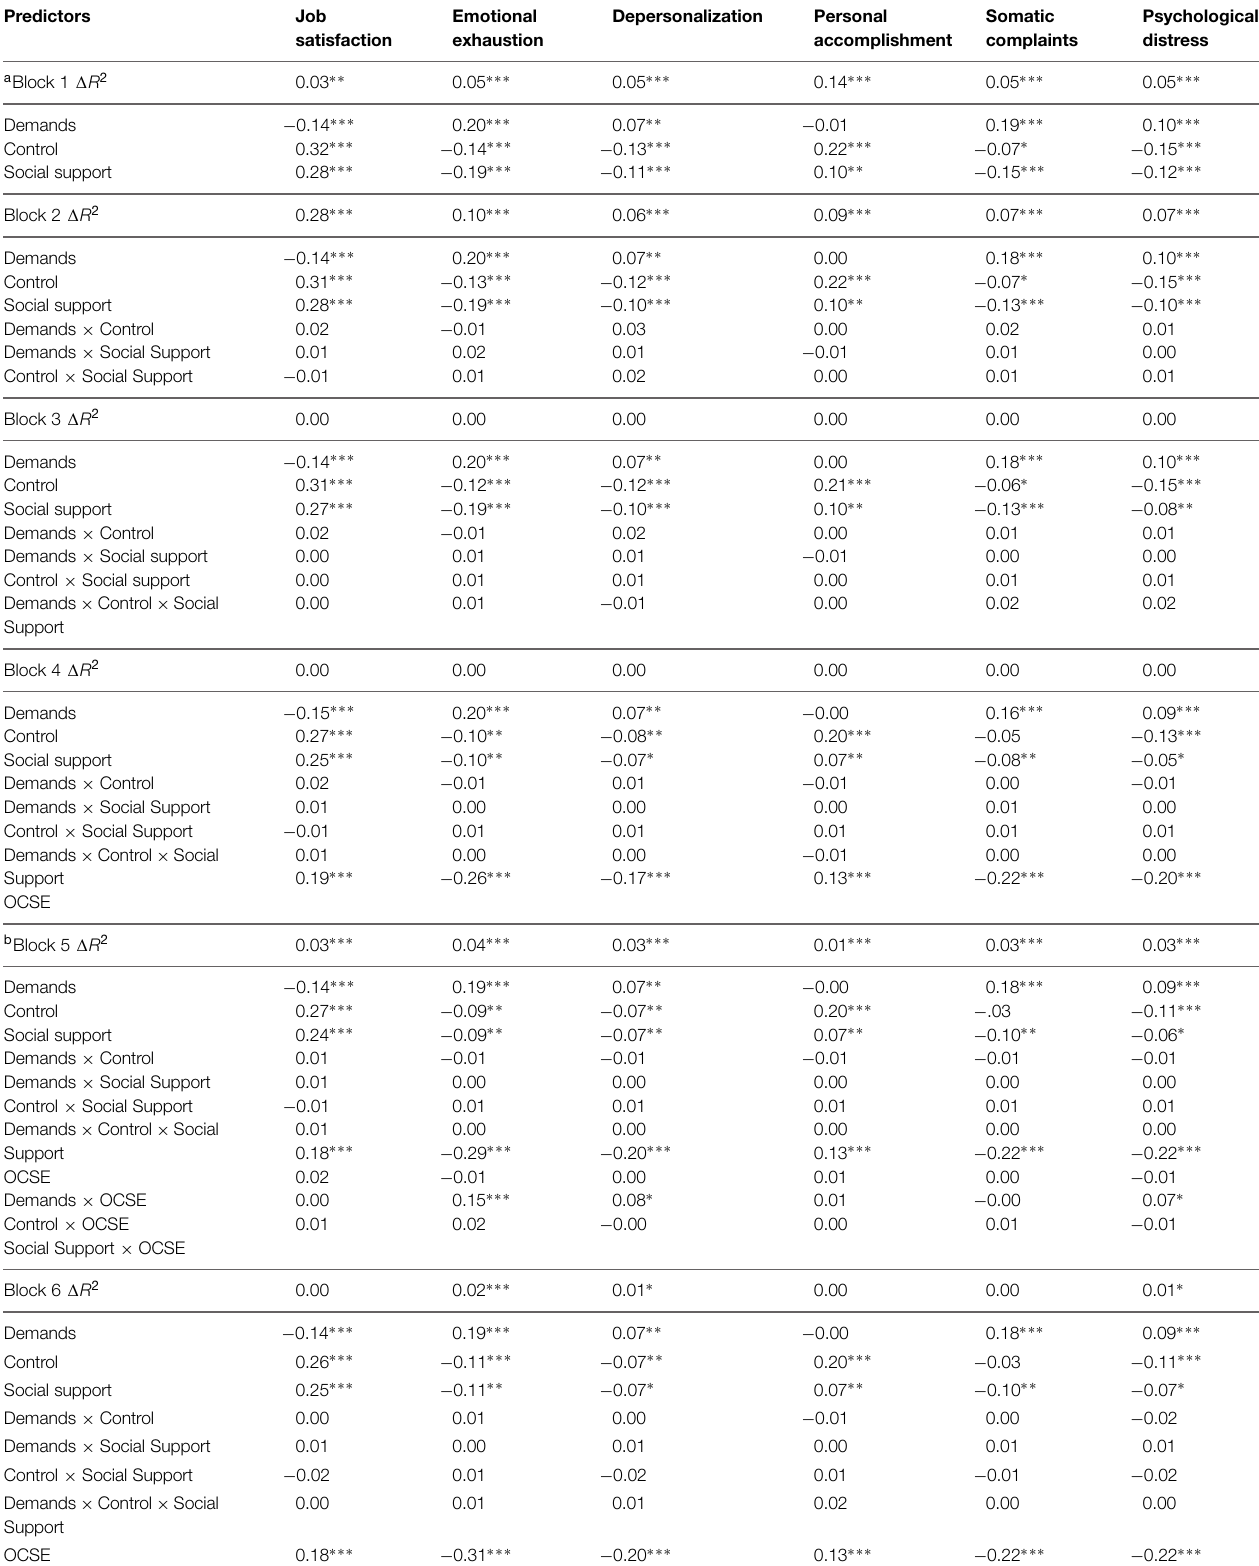
TABLE 2 | Distress/well-being outcomes regressed on the JDCS variables, Occupational Coping Self-efficacy, and their interactions. Predictors Job Emotional satisfaction exhaustion